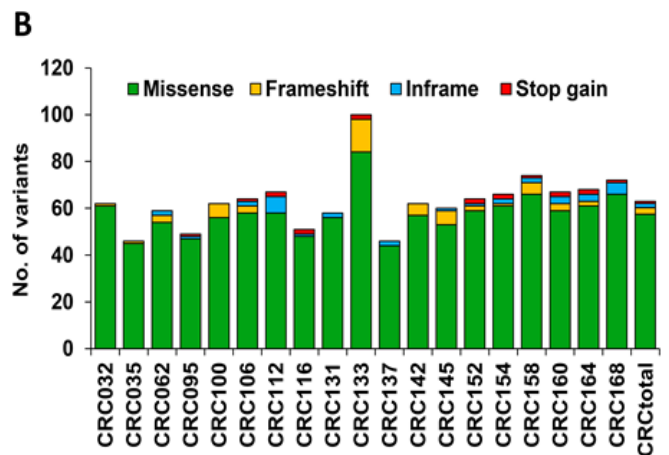
Figure 1. Overview of the variant distribution detected in cfDNA of CRC patients by TST170. ( A ) Global distribution of SNVs and indels in mCRC patients. ( B ) Distribution of SNVs and indels in mCRC patients according to variant type. The term “CRCtotal” represents the mean for all CRC patients analyzed of total variants detected per patient.